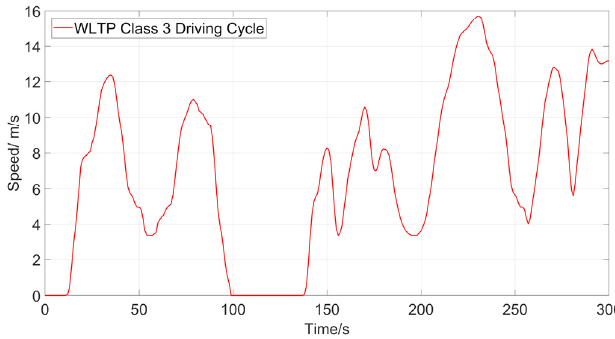
Figure 9. WLTP class 3 driving cycle profile.